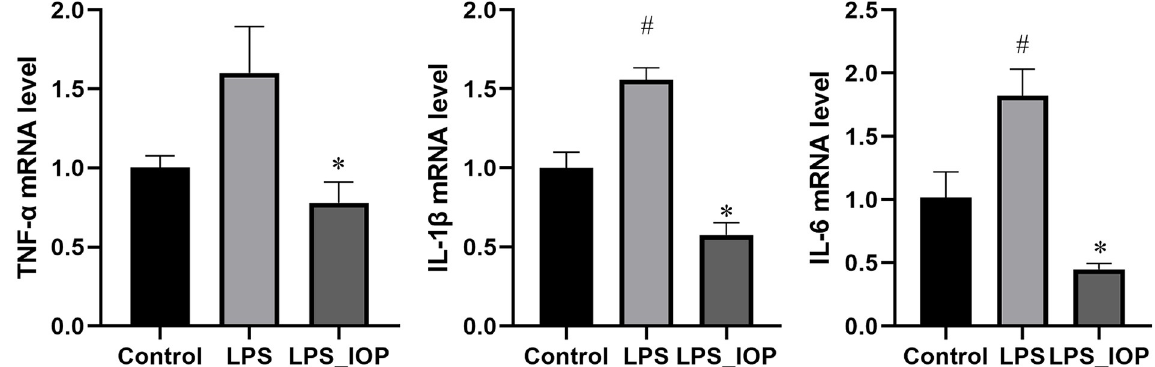
Fig 2. Effects of IOP on inflammatory cytokines TNF- α , IL-6, IL-1 β . Mean ± SD was used for data processing. Three replicates were processed in each group. # P < 0.05 vs. Control group, � P < 0.05vs. LPS group.